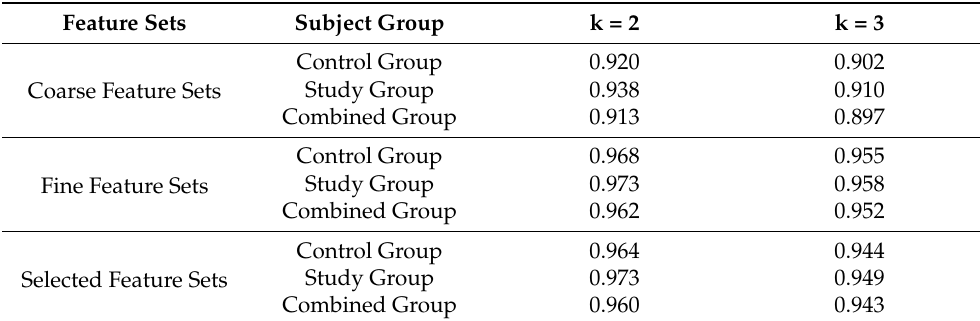
Table 2. Mean F-measure of different subject groups and different feature sets with different synergy number.